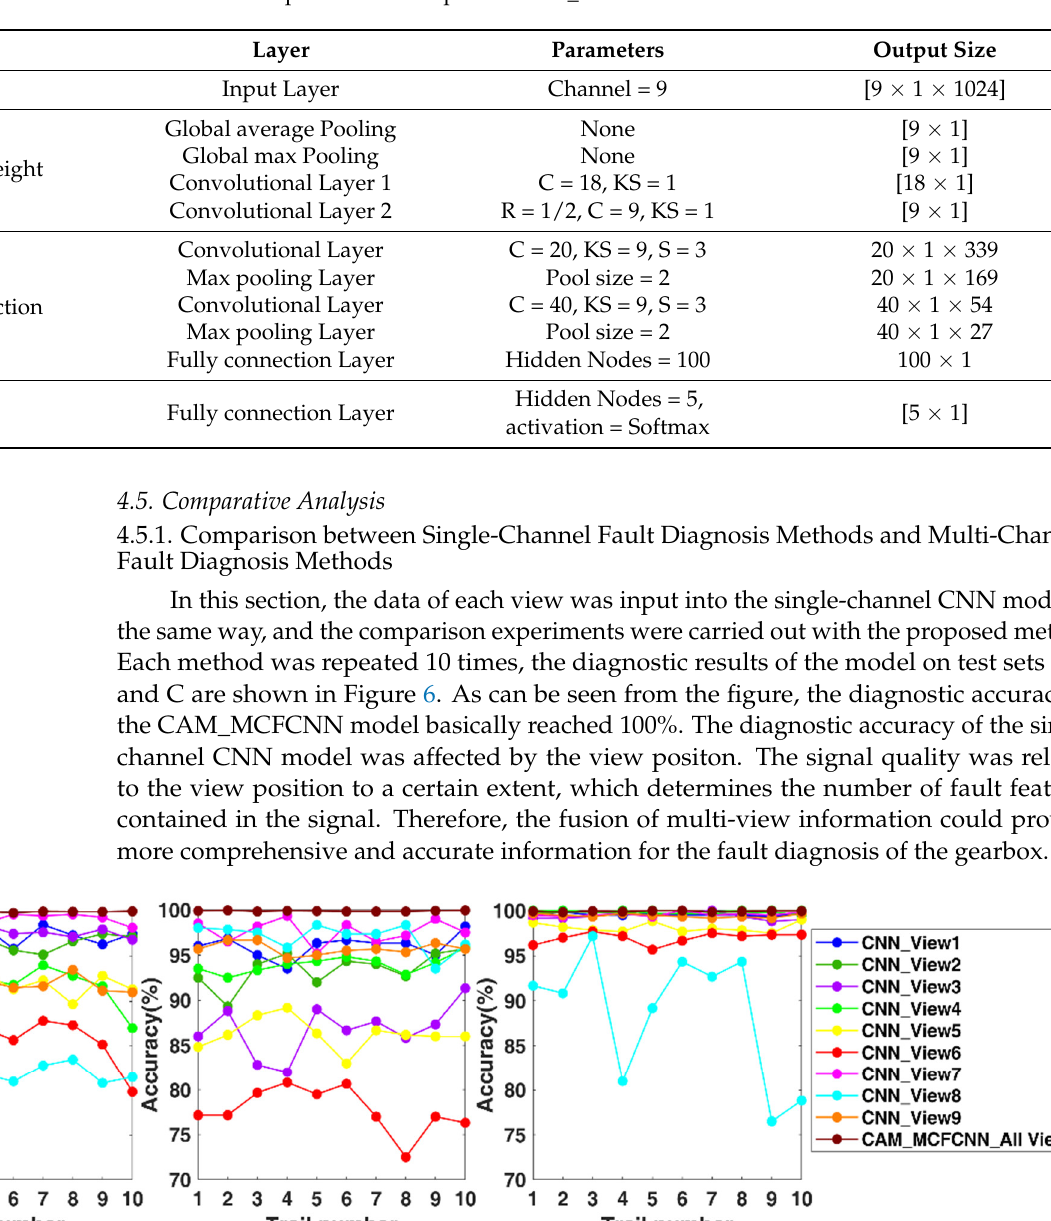
Table 4. Average testing accuracy, standard deviation, and model training average time of single- channel CNN data and CAM_MCFCNN. View Data